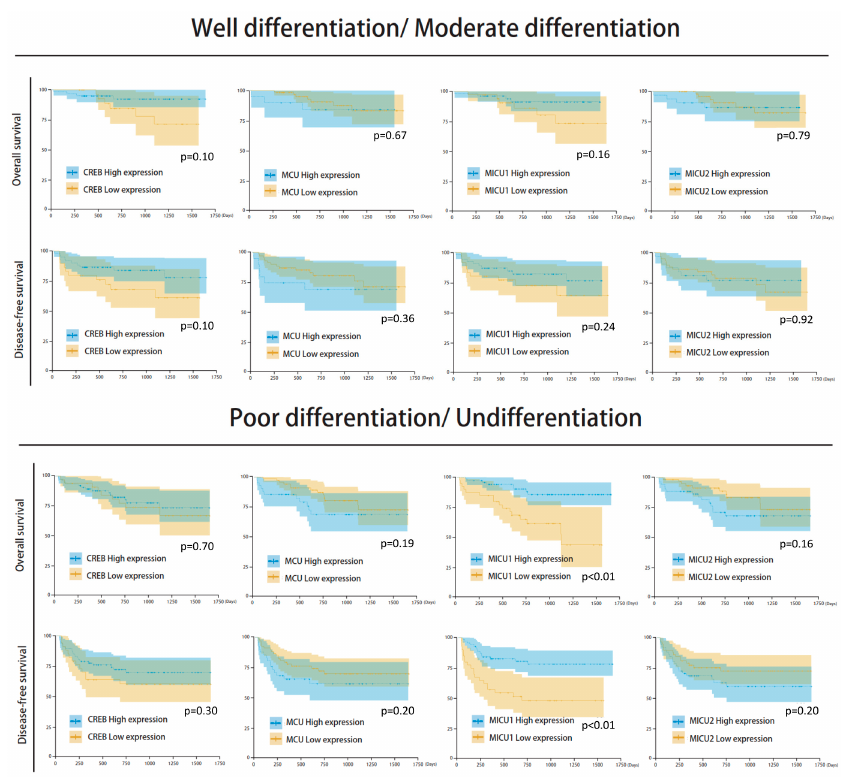
Figure 6. Kaplan–Meier analysis of the four mitochondria gene expression in well/moderate differentiation and poor differentiation/undifferentiation.